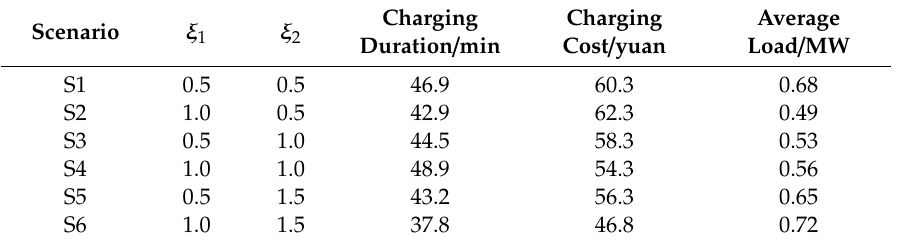
Table 4. Evaluating indicators under di ff erent groups of estimation